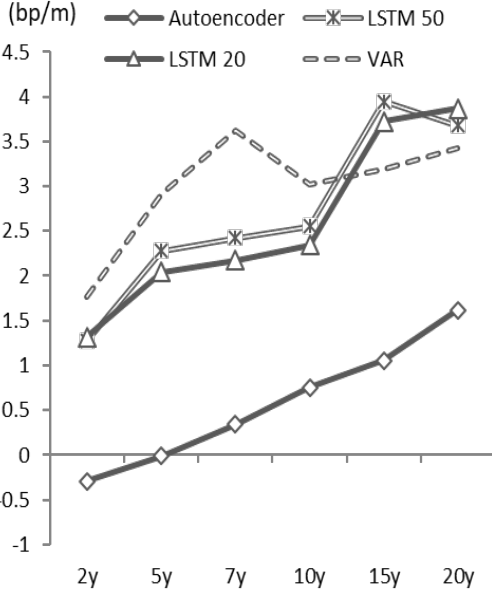
Figure 19. Average monthly capital gains using the LTSM, VAR and autoencoder-based models’ learning period of 5 years and an investment period of 1 month.